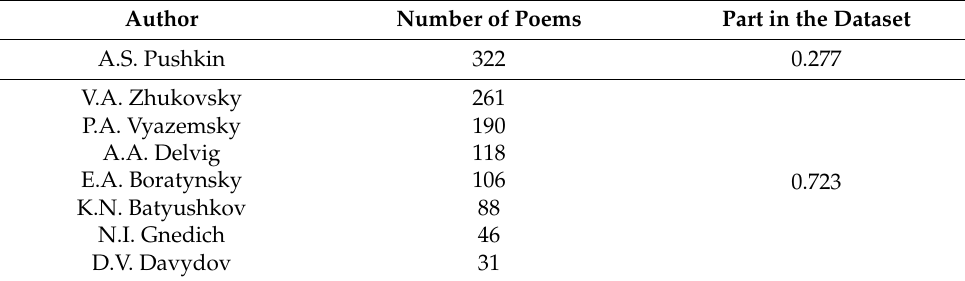
Figure 2. The syntax tree for a sentence from Shakespeare ’ s Sonnet 98.